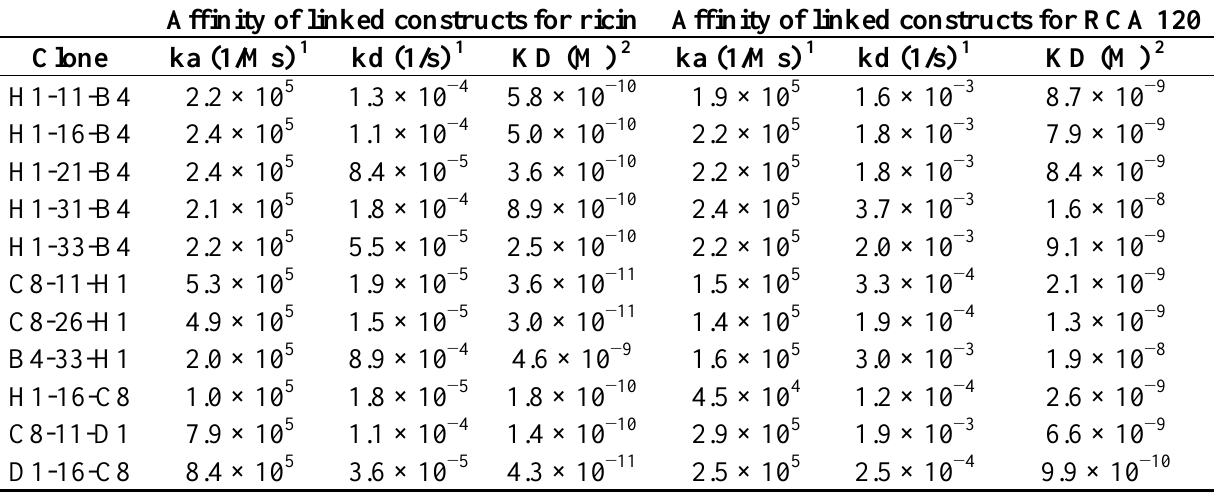
Table 3. Affinity of linked constructs for ricin and